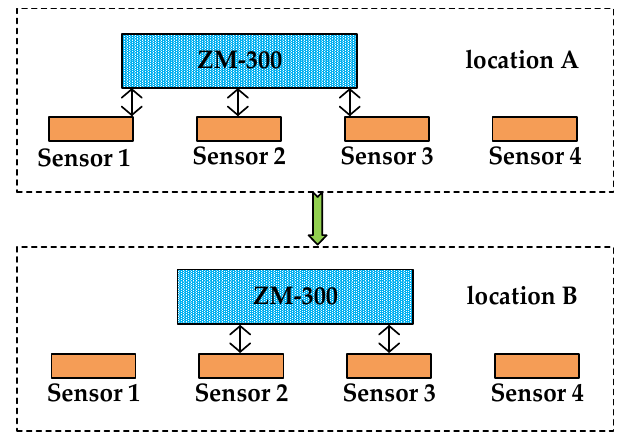
Figure 6. Schematic diagram of sensor contact between SPVG and PAWS at test location A and B.